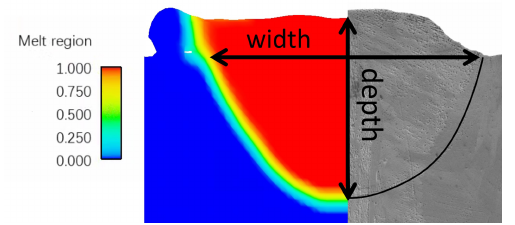
Figure 7. Transverse cross-section ( YZ plane) view of the single laser track. The left part is from simulation result and the right part from experiment